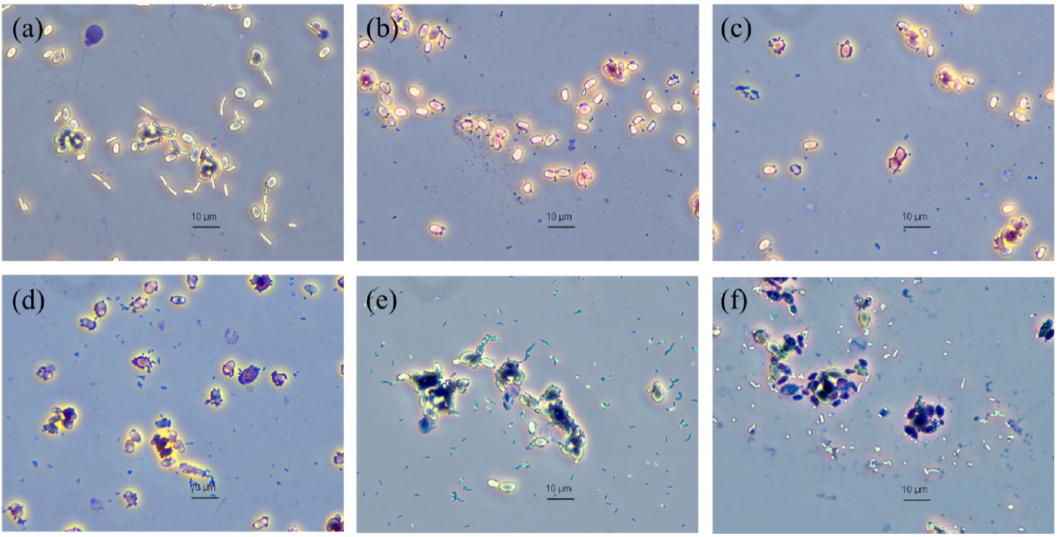
Figure 3. Adherence of ( a ) B. cereus , ( b ) E. coli , ( c ) Staph. aureus , ( d ) Sal. Thyphimurium, ( e ) L. monocytogenes and ( f ) Strep. agalactiae on yeast cell walls observed under a phase-contrast light microscope at 100× magnification.